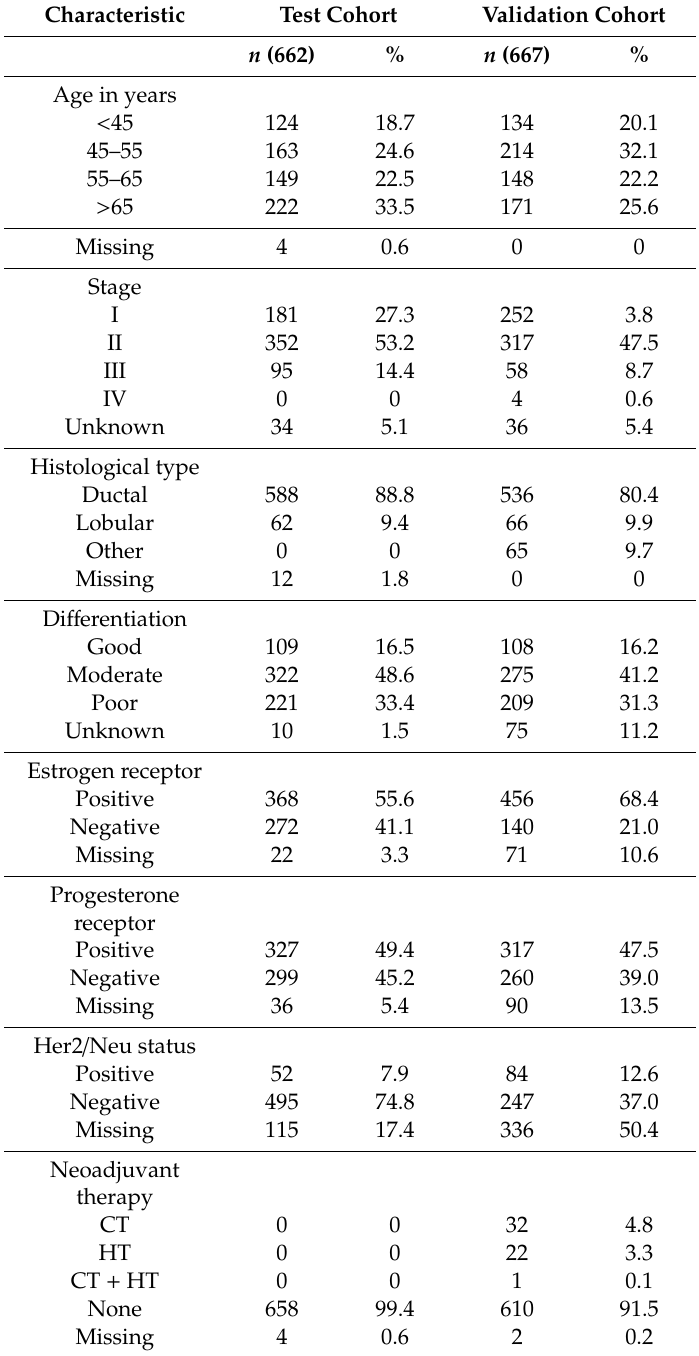
Table 1. Characteristics of breast cancer patients in the test and validation